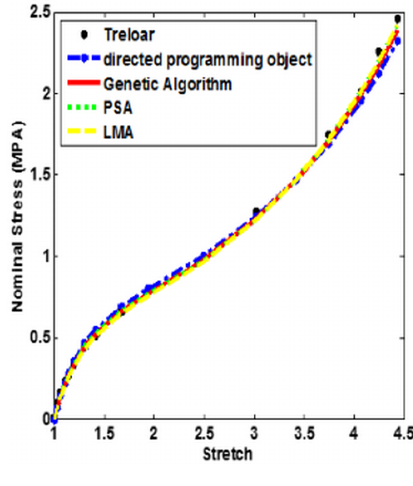
Figure 6: Biaxial tension.